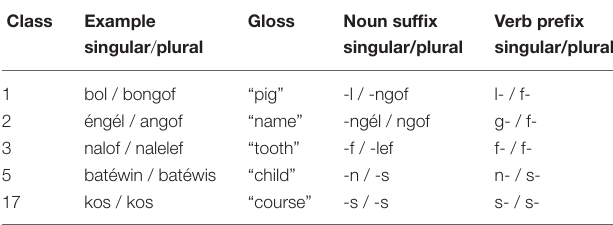
TABLE 1 | A selected set of noun classes in Mufian (Alungum et al., 1978, p. 93).